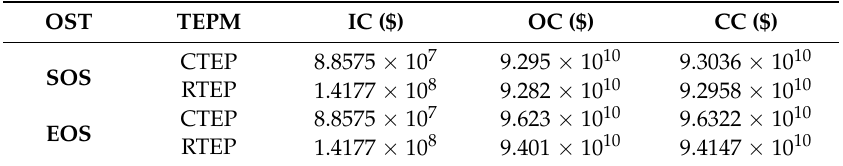
Table 8. Results of the proposed RTEM method and the CTEP method for the IEEE 118-bus system. OST TEPM IC